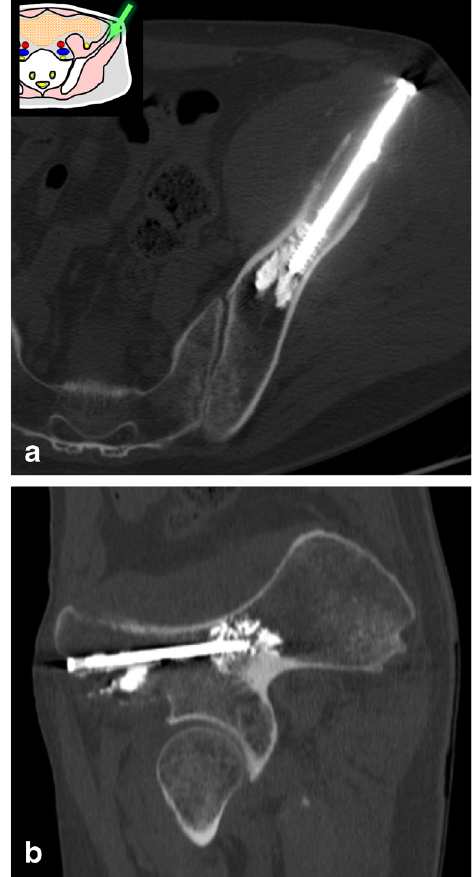
Fig. 24 A 75-year-old man treated for a rectal adenocarcinoma present- ing with a single painful metastasis in the left iliac bone and early path- ological fracture. A cementoplasty combined with percutaneous osteosynthesis was performed along the greater axis of the iliac wing. a Axial CT and b sagittal oblique reconstruction show the screw and the cement in the iliac